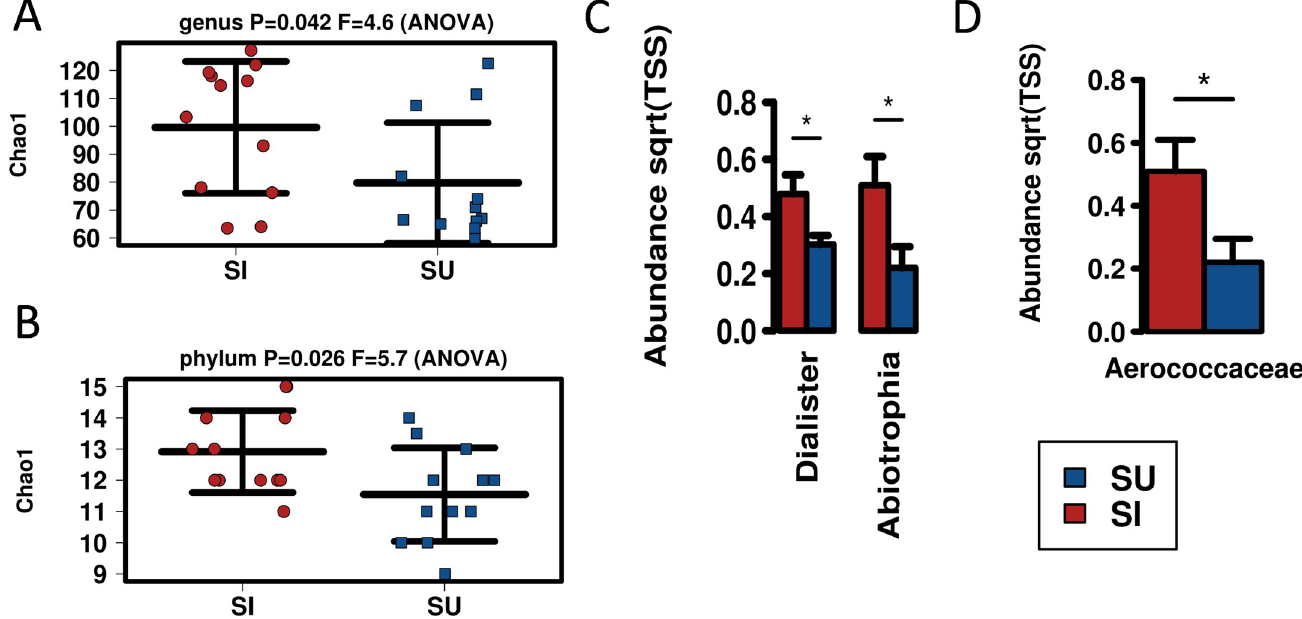
Fig 5. Analysis of saliva samples from infected (red bars) and uninfected (blue bars) participants shows altered microbiota. Chao1 metric indicated elevated alpha diversity associated with infected samples at the A. genus and B. phylum taxa levels. ANOVA identified C. genera, D. family all elevated in infected samples. � = p-value � 0.05. Complete ANOVA data are presented in S4